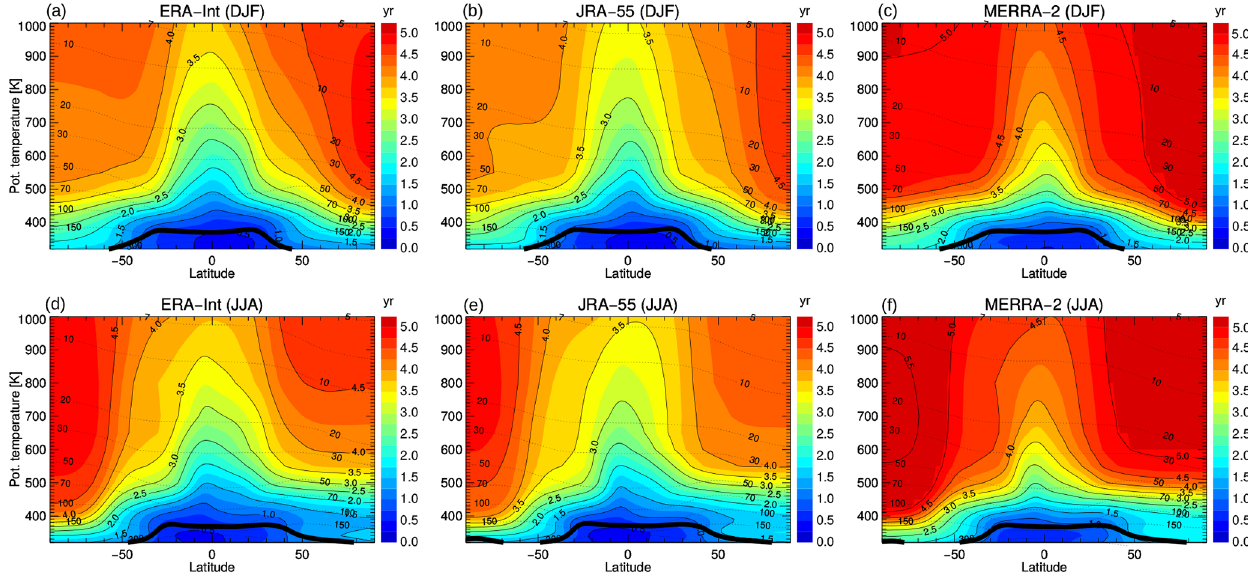
Figure 1. Mean age climatology (1989–2015) for December–February (DJF, a–c ) and June–August (JJA, d–f ) for ERA-Interim (a, d) , JRA- 55 (b, e) and MERRA-2 (c, f) . Thin solid black lines highlight particular mean age contours, the thin dashed black lines show pressure levels in hPa, and the thick black line is the (lapse rate) tropopause (calculated from each reanalysis following WMO,